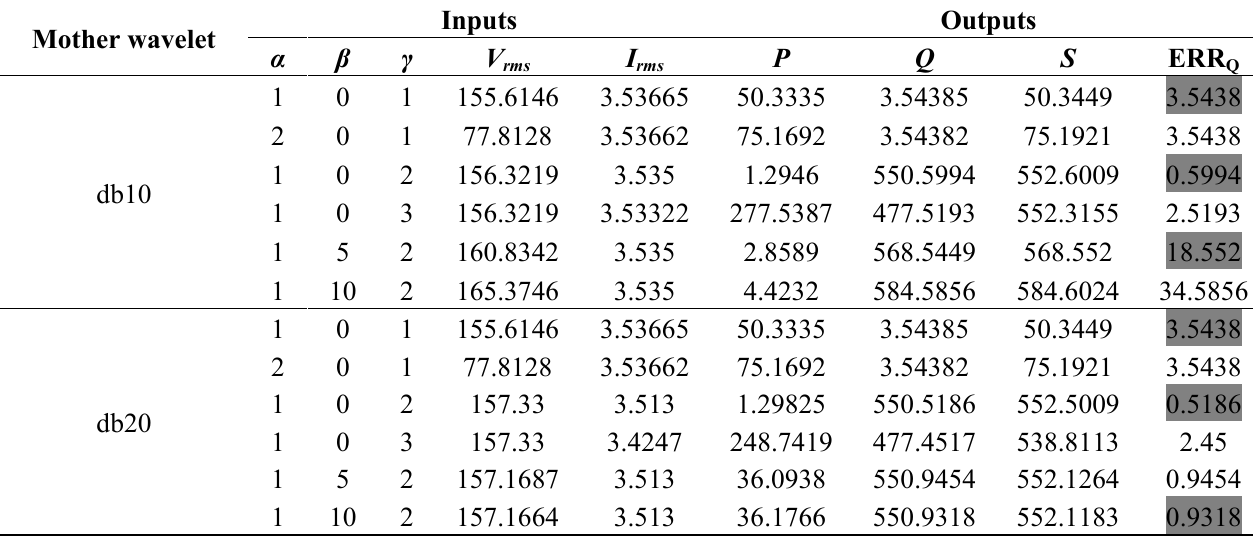
Table 4. Results for case study 2.